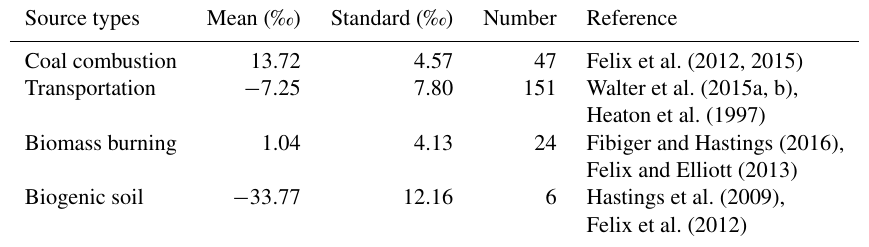
Table B1. Typical δ 15 N-NO x values for coal combustion, transportation, biomass burning, and soils based on literature